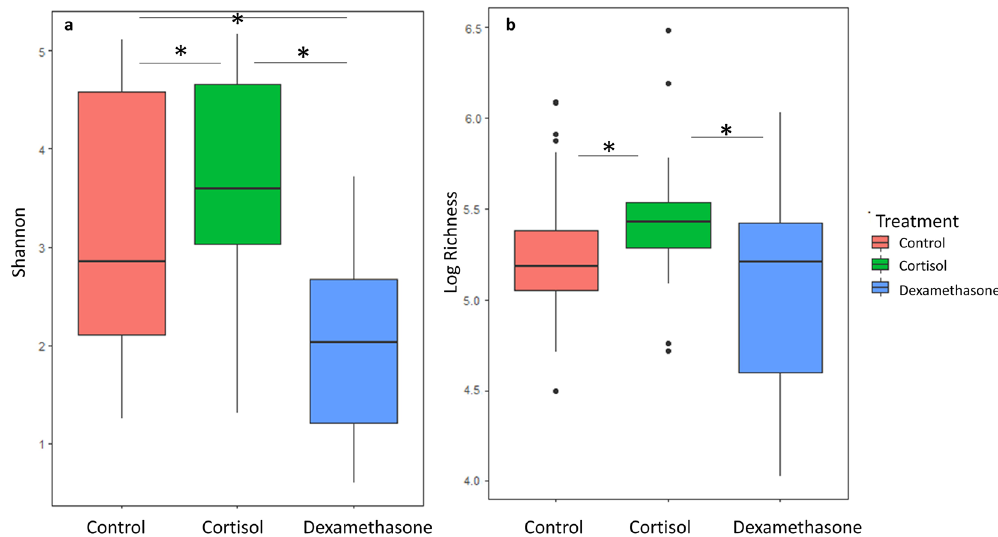
Figure 1. Boxplots of Shannon diversity ( a ) and log-transformed ASV richness ( b ) of juvenile gut microbiome samples from both time points (three and seven weeks post-treatment). The horizontal line bisecting the box indicates the median, the lower and upper hinges correspond to the first and third quartiles, and the upper and lower whiskers extend to the largest and smallest values no further than 1.5 IQR from the adjacent hinge. Significant differences between treatment groups are indicated with a line and an asterisk.